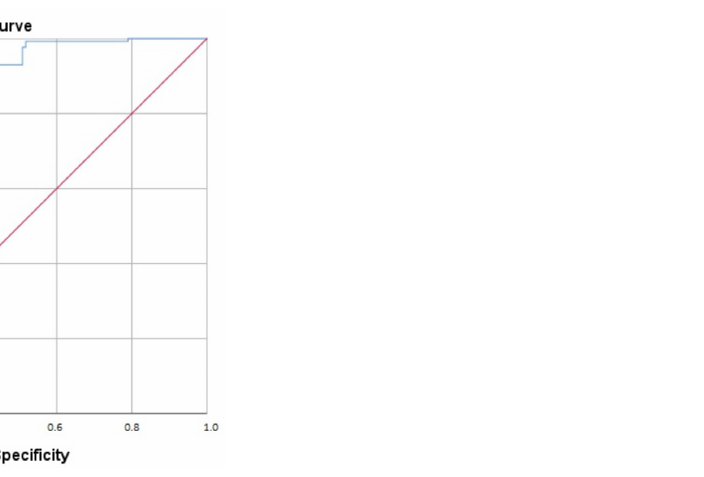
Figure 2. Receiver operator characteristics (ROC) curve of multiple regression analysis model in predicting ARDS. Legend: Blue line—ROC curve, red line—diagonal reference